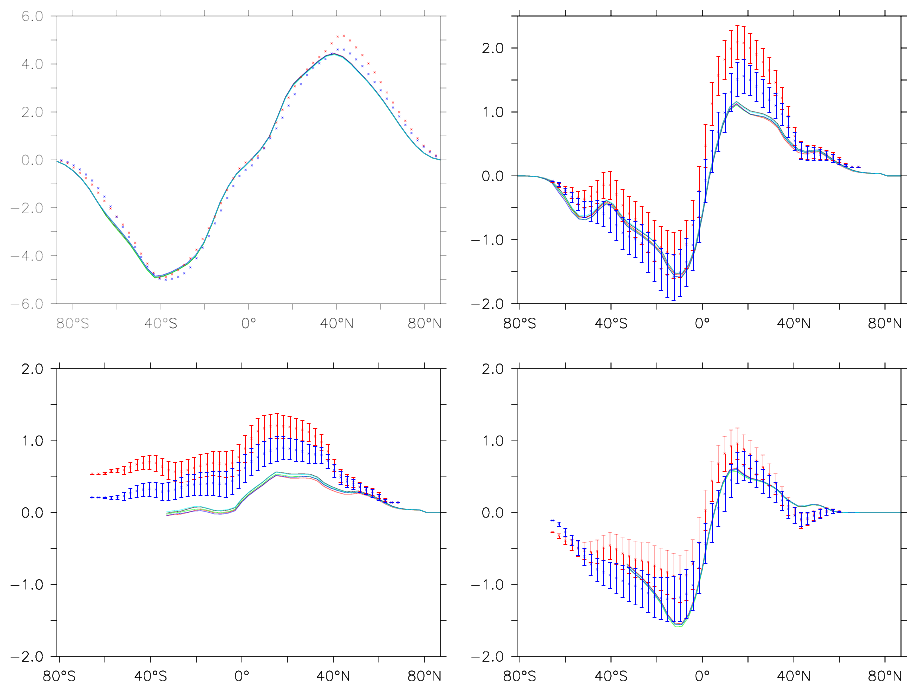
Fig. 11. The global atmospheric (upper left), global ocean (upper right), Atlantic ocean (lower left), and Indo-Pacific ocean (lower right) heat transport in PW for each member of the SPEEDO ensemble (solid lines). Positive values indicate northward transport. The reanalysis data by Trenberth and Caron (2001) for the NCEP-NCAR (red) and ERA15 (blue) are shown with crosses. The ocean heat transports are derived using an inverse modelling method. For these data the one standard deviation uncertainty in the inverse modelling results are indicated by error